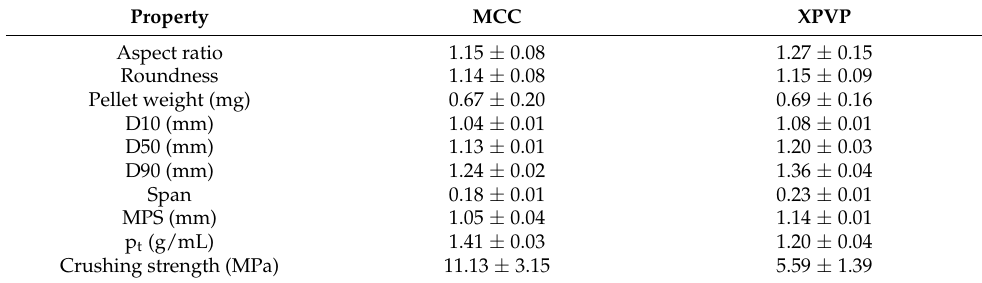
Table 3. Physical properties of coated pellets. Mean values shown with the standard deviation.